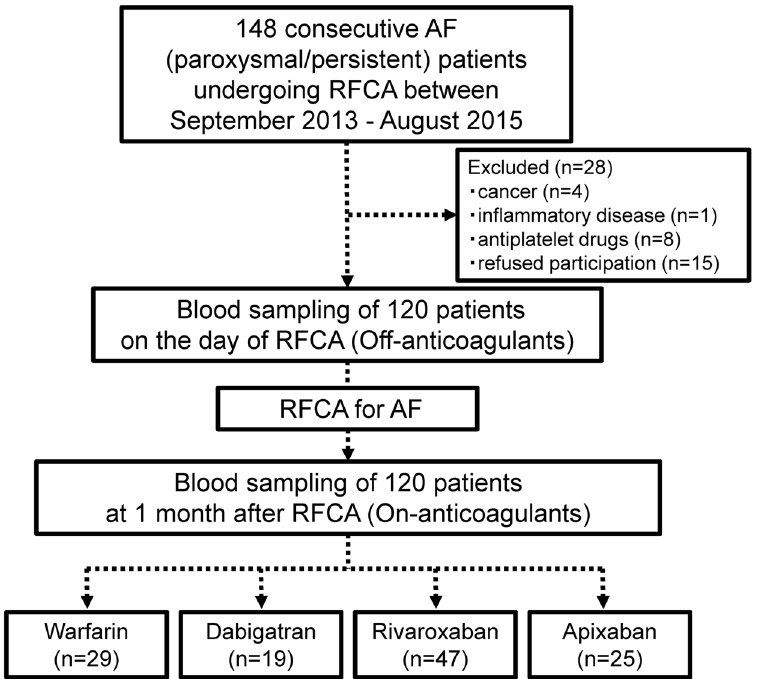
Figure 1. Study flow chart. Chart showing the enrollment criteria and division of patients into different anticoagulant treatment groups. AF = atrial fibrillation, RFCA = radiofrequency catheter